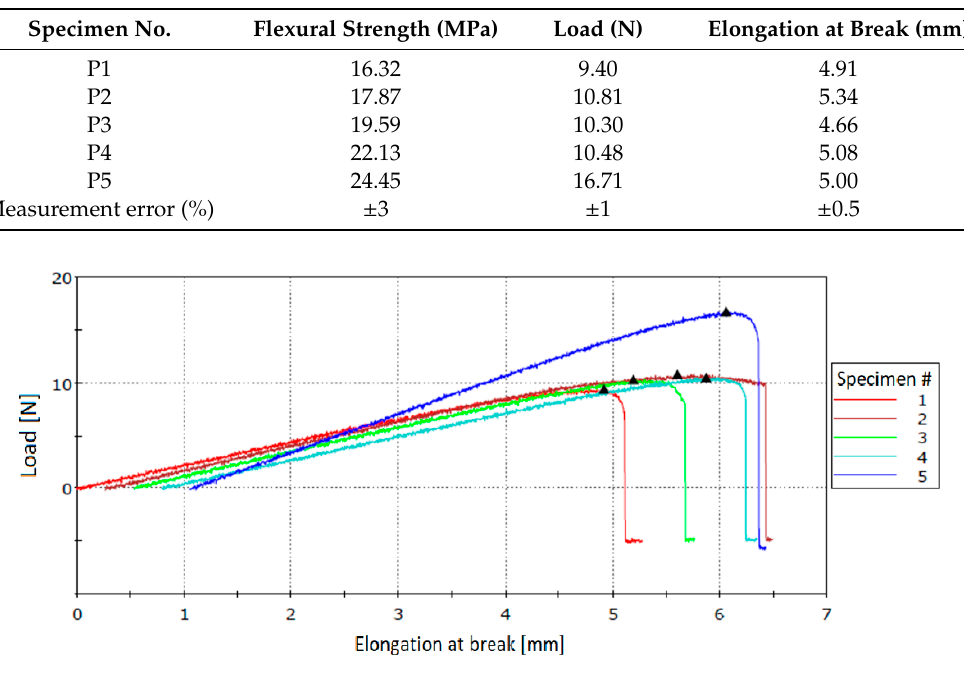
Figure 27. Stress–strain curves for MUF-ENB specimens fabricated according to method 6.